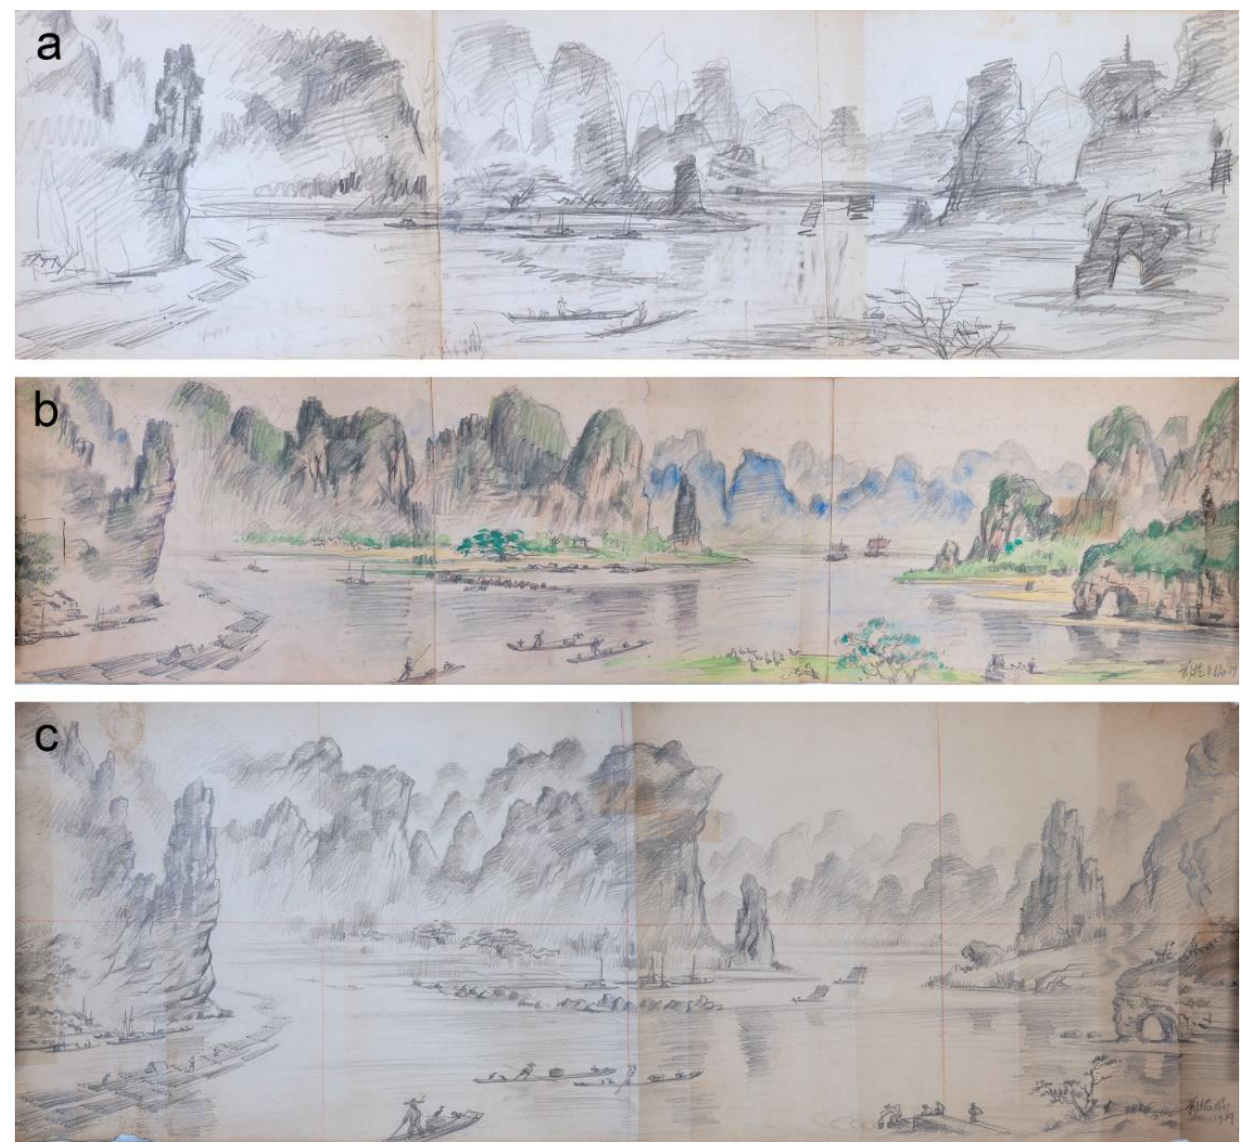
Figure 19. ( a ) Liu Kang, untitled, undated, pencil on paper, 26 × 88 cm; ( b ) Liu Kang, untitled, 1979, pencil and watercolour on paper, 28 × 107 cm; ( c ) Liu Kang, untitled, 1979, pencil on paper, 38 × 107 cm. Liu Kang family collection. Images courtesy of Liu family.